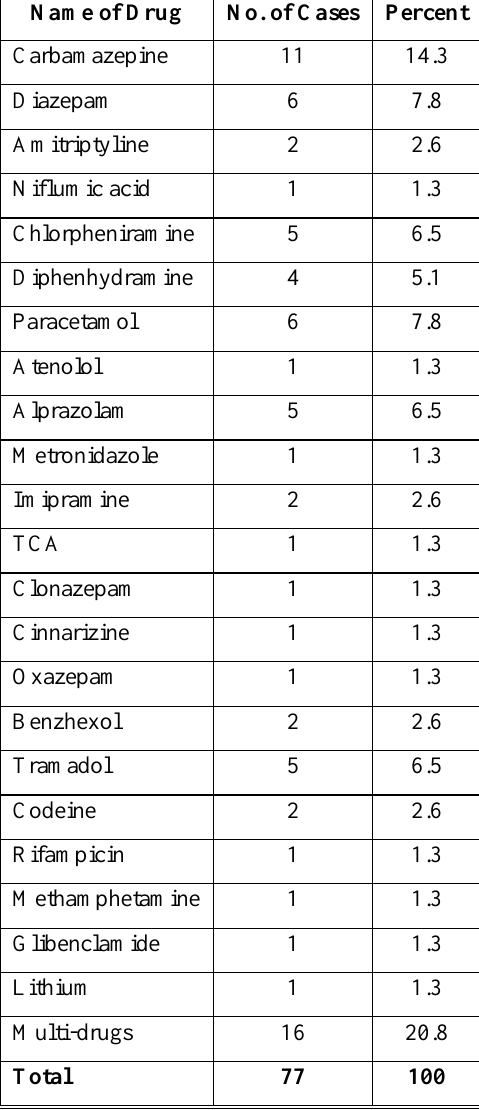
Table (2): Incidence of drugs-induced poisoning reported in Baghdad PCC during 2013 distributed according to drug